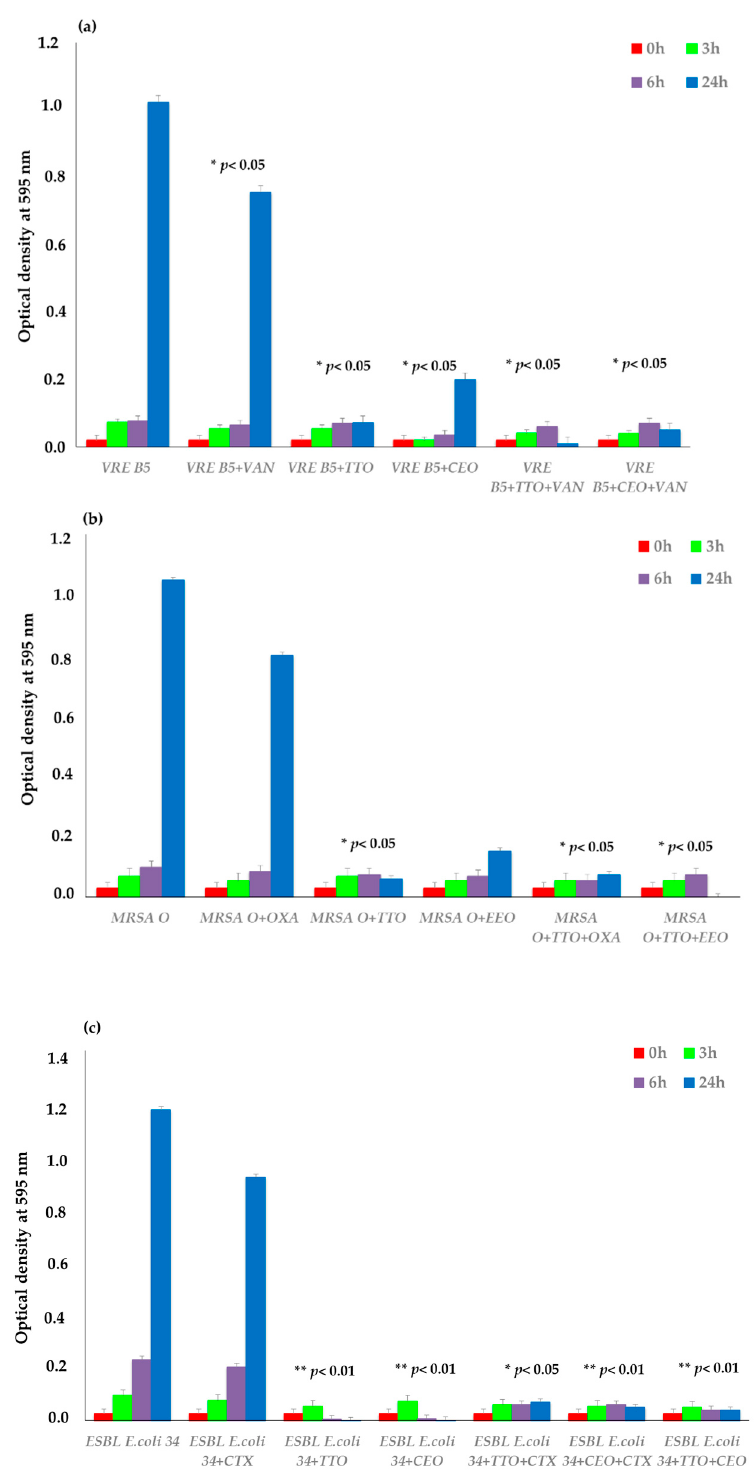
Figure 2. Time–kill studies of EOs, antimicrobials (VAN, OXA, and CTX), and the different com- binations (EO–EO, EO–antimicrobial) against VRE B5 ( a ), MRSA O ( b ), and ESBL E. coli 34 ( c ) strains. p -values of <0.05 (*), <0.01 (**) were considered significant by t-test and